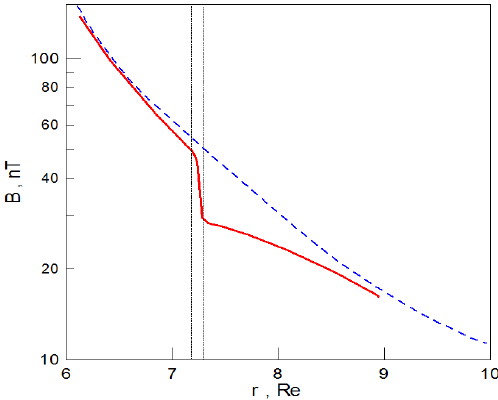
Figure 10. Undisturbed equatorial B z profile (blue dashed line) and hypothetical “magnetic-wall-type” profile (red line) which can pro- vide “no-dispersion” isotropy boundary